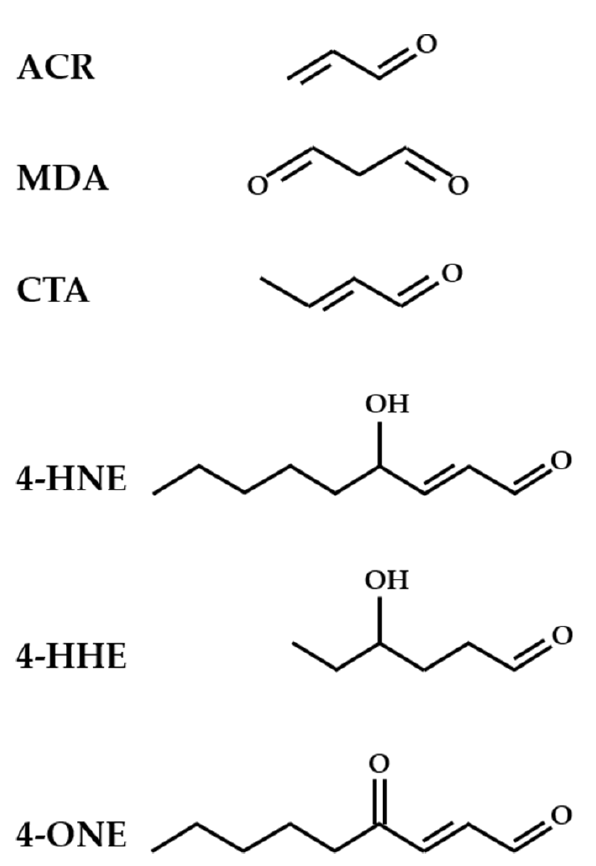
Figure 2. Chemical structures of the main reactive aldehydes produced by lipid peroxidation. ACR: acrolein; MDA: malondialdehyde; CTA: crotonaldehyde; 4-HNE: 4-hydroxy-2-nonenal; 4-HHE: 4-hydroxy-hexanal; 4-ONE: 4-oxo-nonenal.